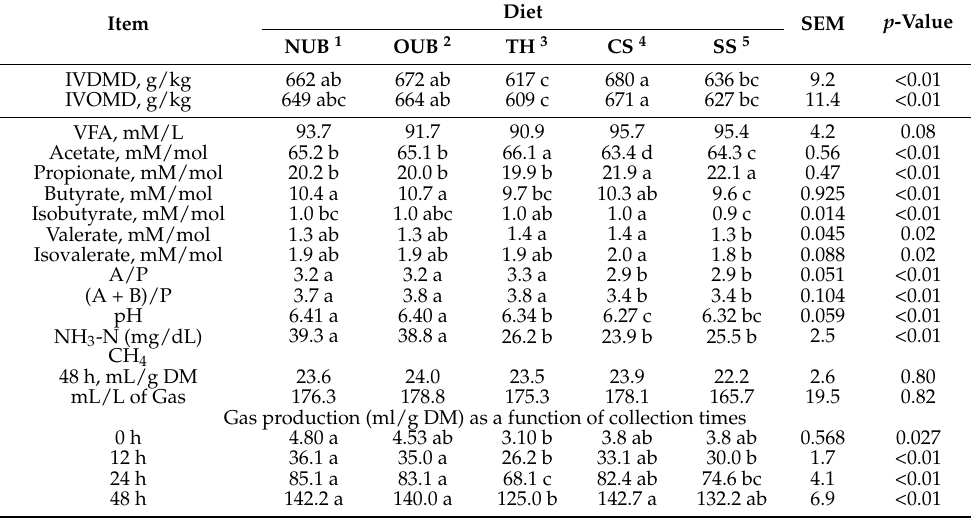
Table 6. Effect of experimental diets on in vitro fermentation and methane